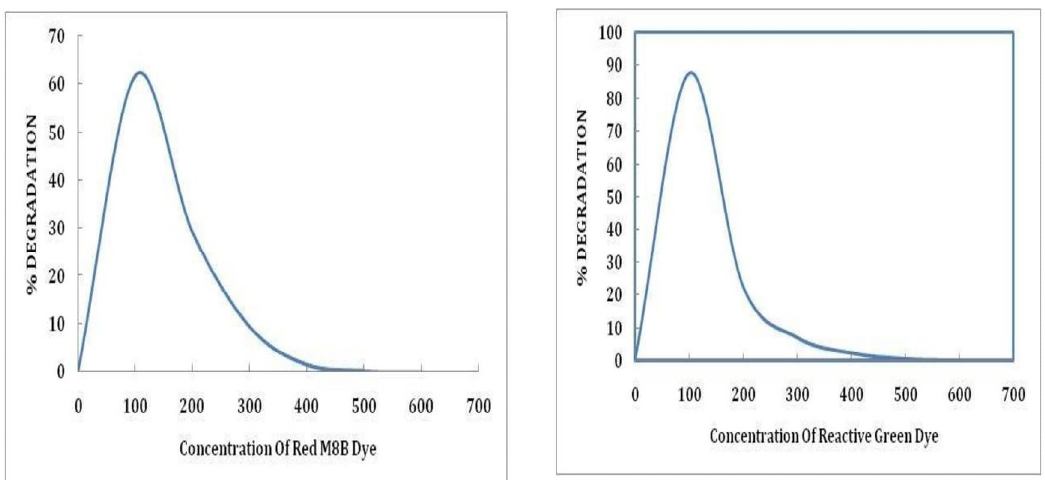
Fig. 14. Percent Degradation of Red M8B and Reactive Green Dye at different